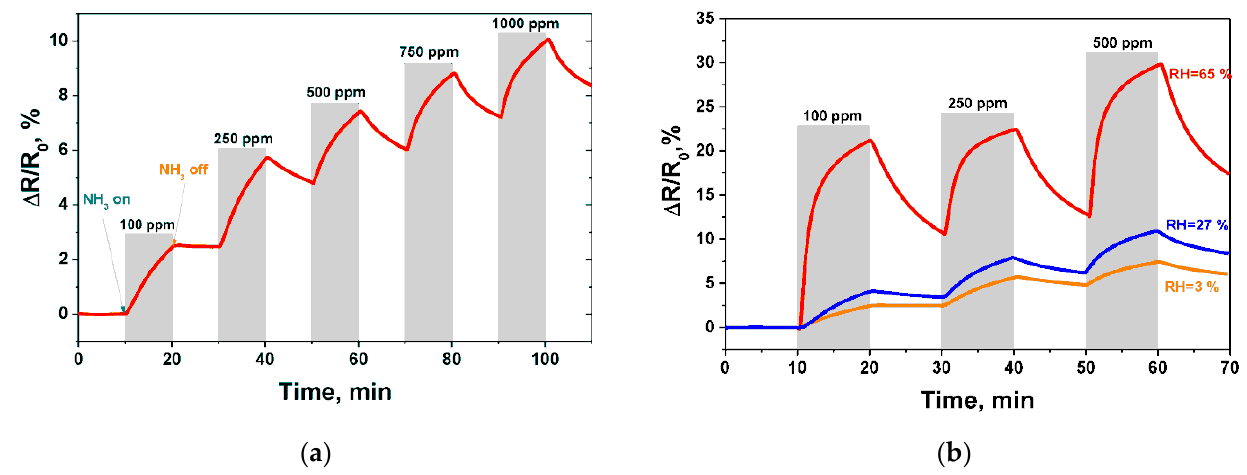
Figure 7. Chemiresistive sensor operating at room temperature: ( a ) Response to ammonia in the range of concentrations from 100 ppm to 1000 ppm (RH = 3%); ( b ) Response to ammonia at various relative humidity levels [92]. With the permission of MDPI.